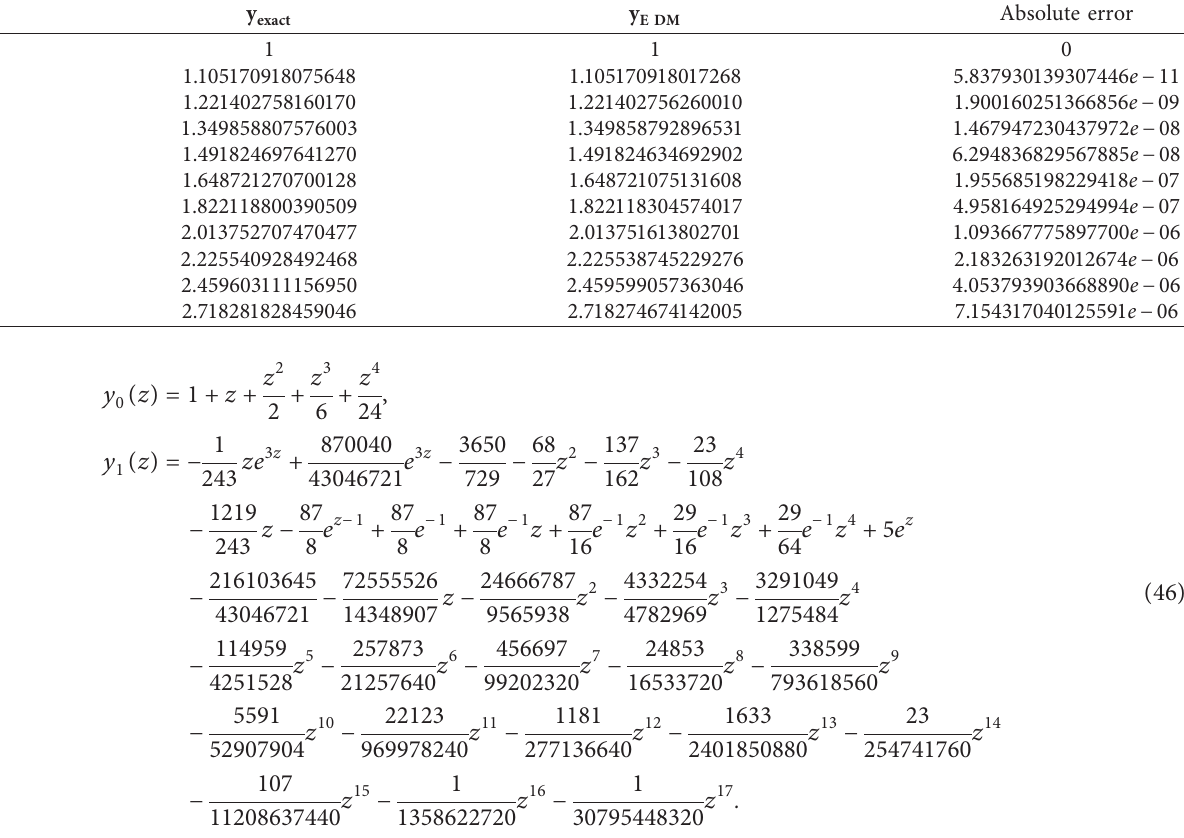
with y for Example 3. EDM exact and y for Example EDM exact